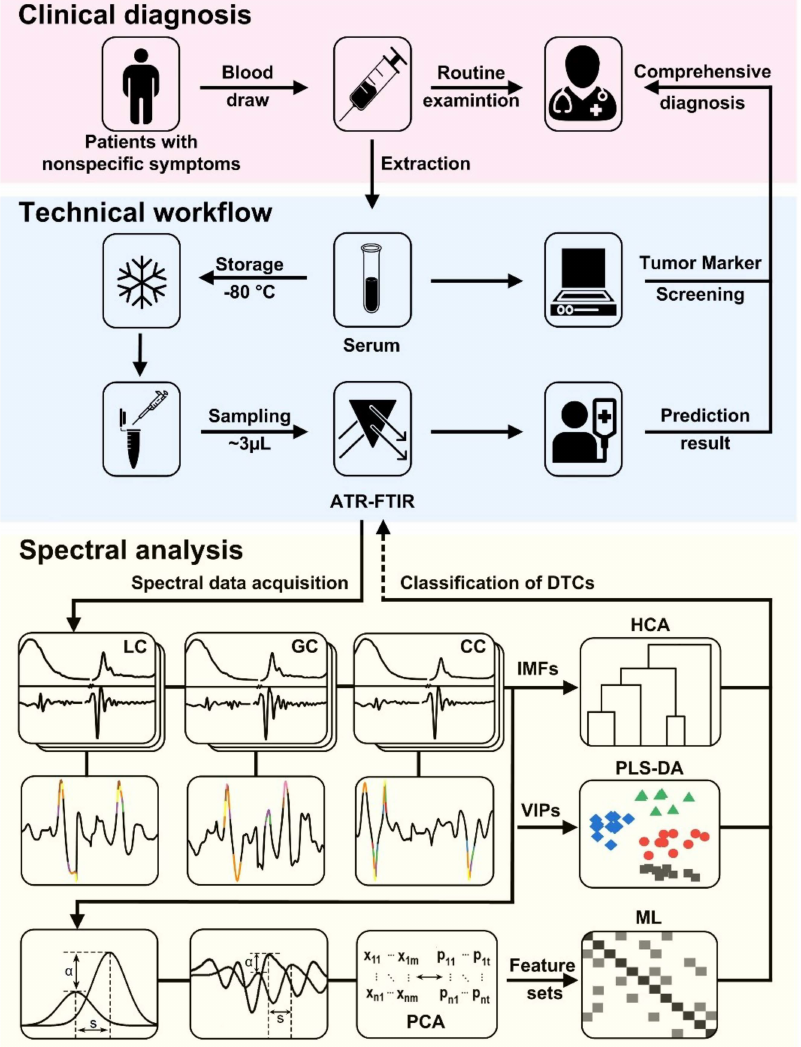
Figure 1. Serum-based ATR-FTIR spectroscopy testing and data mining pathway for accurate DTC triages. The DTC patients with non-specific symptoms could be effectively screened, potentially improving diagnosis efficiency. The different colored symbols (triangles, circles, etc.) represent different